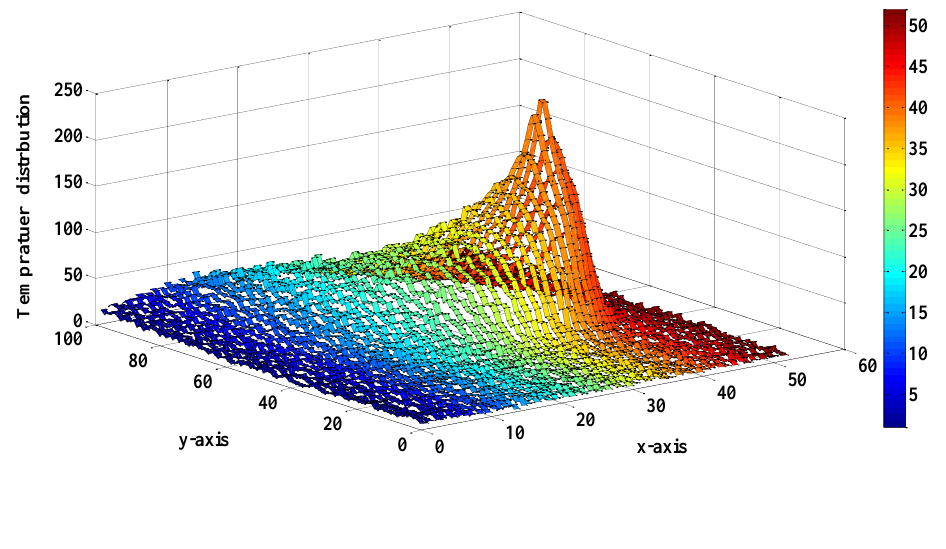
Fig. 4: Perspective plot of (T